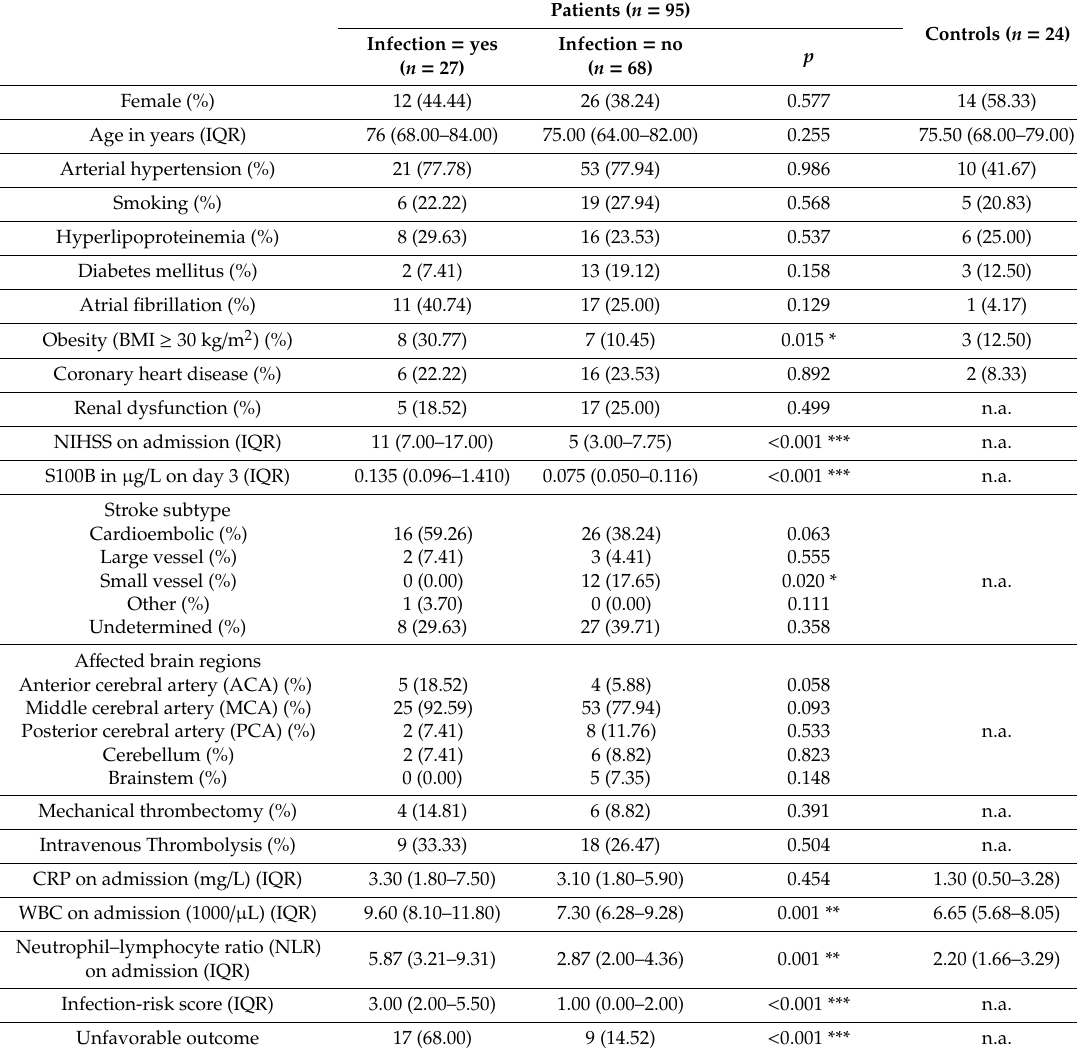
Table 1. Patient´s and control´s